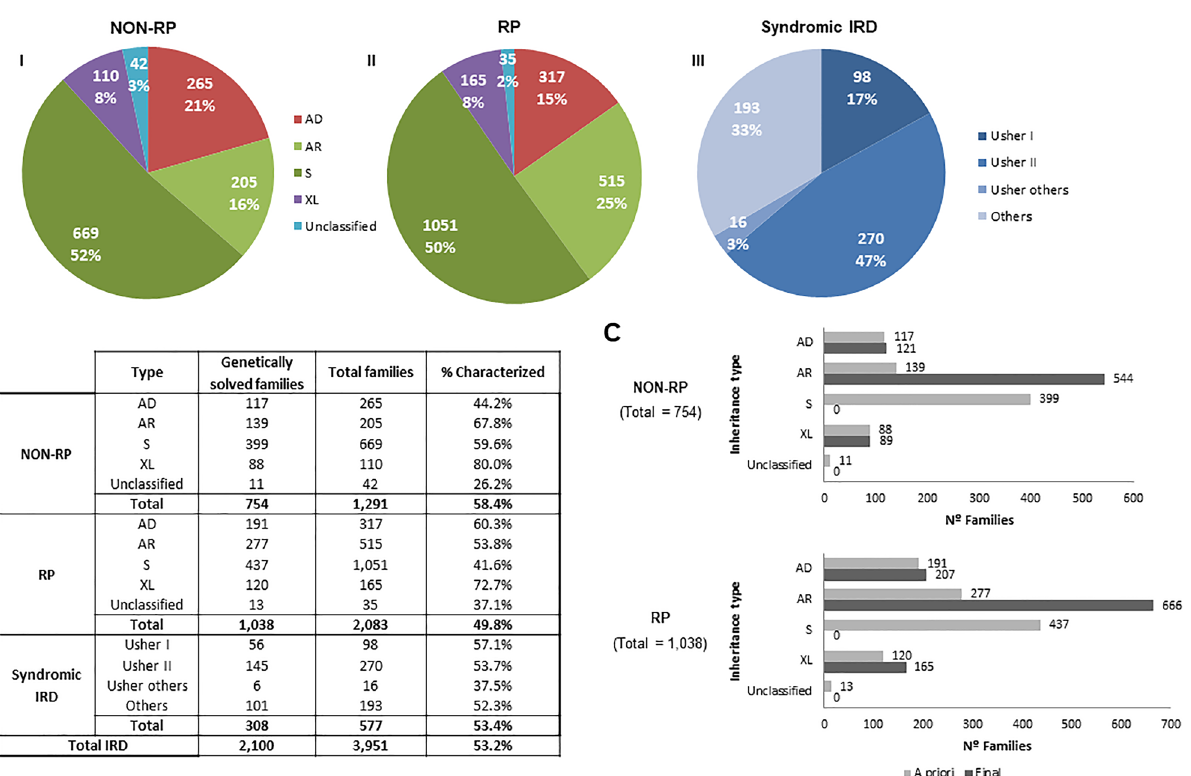
Figure 2. “A priori” and final classification of IRD affected cases. ( A ) “A priori” classification of IRD families with data obtained from the clinical and family history of the patients, before performing molecular tests: NON-RP (I), RP (II), and syndromic IRD (III), and subclassification according to the inheritance type in case of RP and NON-RP, and type of syndrome in case of syndromic IRD. Data obtained with the clinical and familiar history of the patients, before performing molecular tests. AD Autosomal Dominant, AR autosomal recessive, S sporadic, XL X-linked. ( B ) Proportion of genetically solved NON-RP, RP, syndromic IRD and total IRD. The diagnostic ratio in the different group of NON-RP and RP by the type of “a priori” inheritance and in the different group of syndromic IRD by type of syndrome is indicated. ( C ) Genetically solved families. Comparison of inheritance classification before (light gray) and after (dark gray) the molecular study was performed.